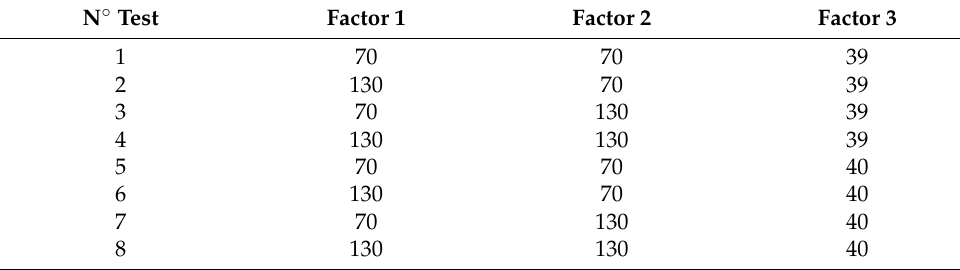
Table 3. The values of the factors studied with no coding unit.